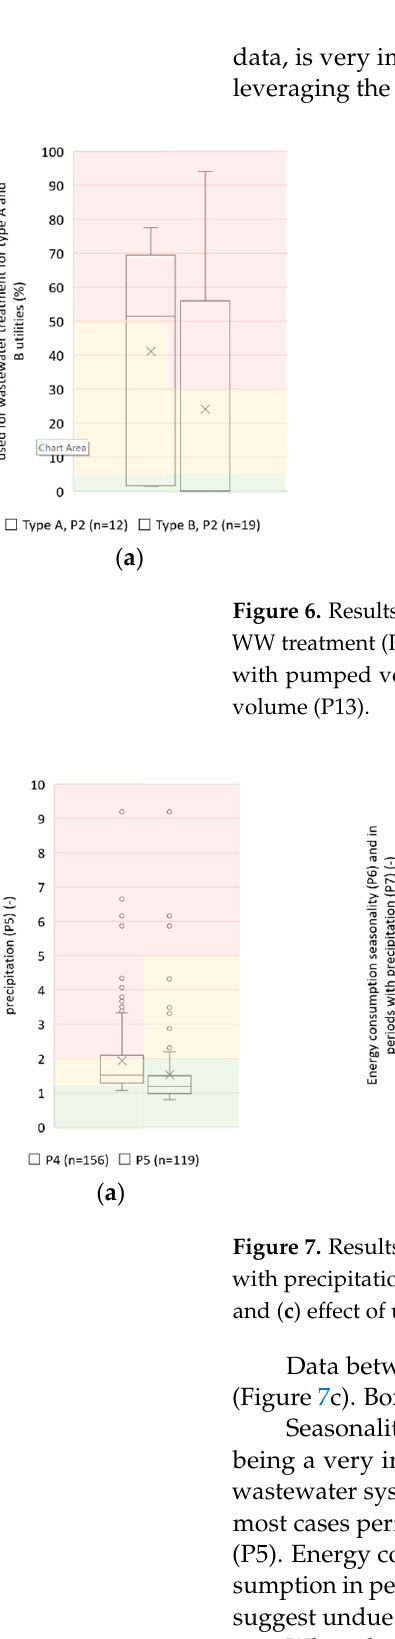
( b ) Figure 5 . Results of evaluation at national level for ( a ) percentage of total energy consumption used for pumping (P1) for type A utilities (left) and type B utilities (right) and ( b ) specific GHG emissions associated with wastewater treated volume (P11). 4.2. W ‐ E ‐ G Nexus at Utility Level: The Case of Nine Portuguese Utilities The metrics were calculated using the data from the utilities. At the utility level, the results presented originate from measurement locations that were audited by the research